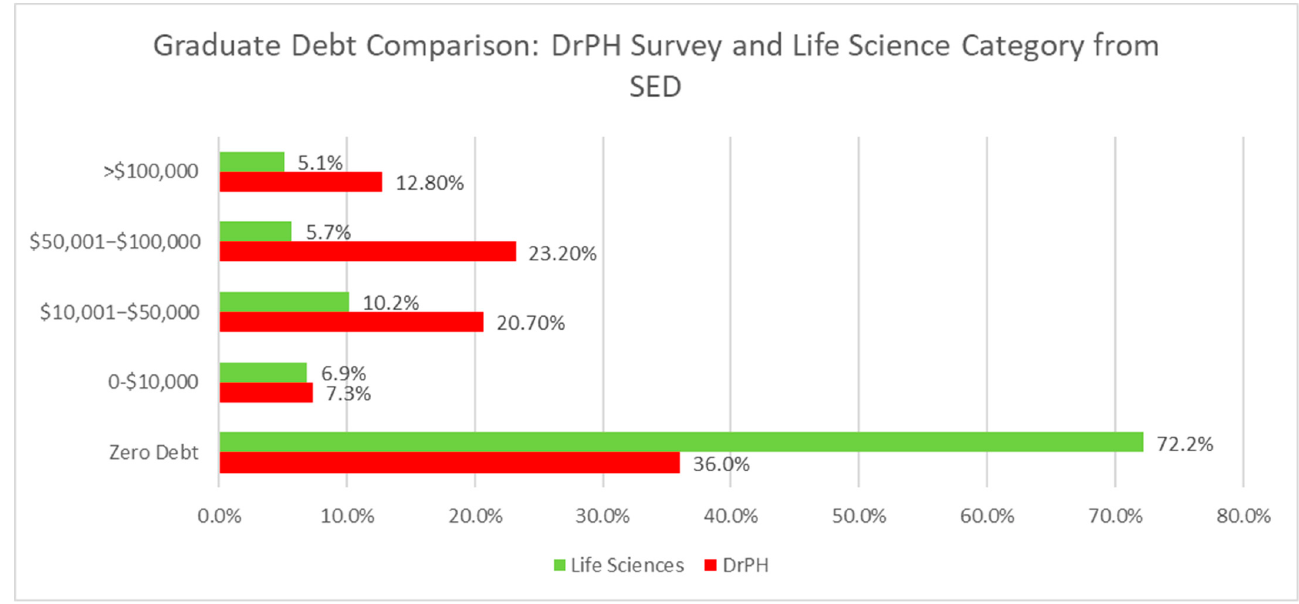
Figure 1. The debt comparison of the DrPH and Life Science categories from SED. Table 4. The financing differences between debt career